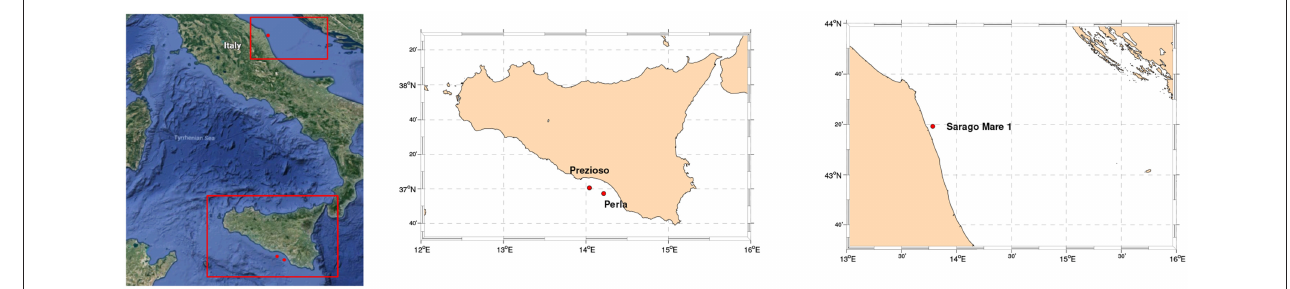
FIGURE 1 | Localization of the three extraction platforms object of study (Left) in the Italian seas; Zoom in the Sicily Strait ( Central , Prezioso and Perla platforms) and in the Adriatic Sea ( Right , Sarago Mare